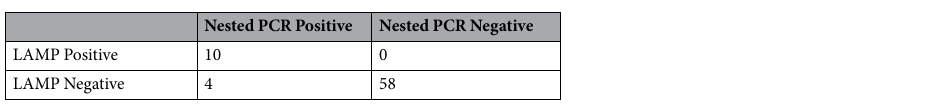
Table 1. Comparison of ITS1 nested-PCR and colorimetric Mp419 LAMP assays for detection of M . perstans in C . milnei .